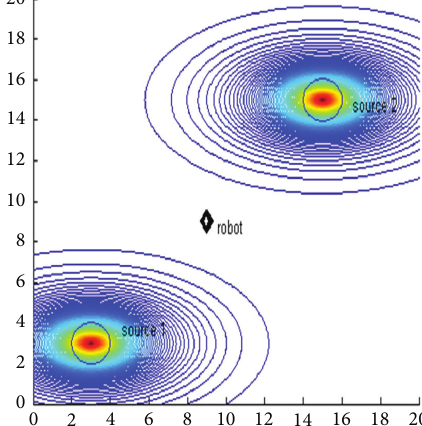
Figure 9: Falling the local optima trap with PD and